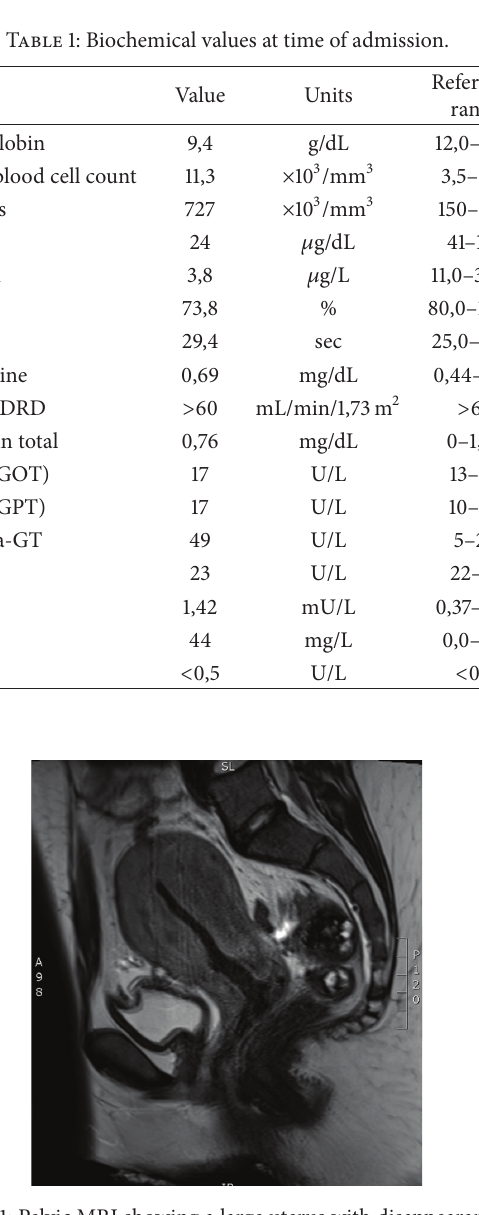
Figure 1: Pelvic MRI showing a large uterus with disappearance of its zonal anatomy, yet lacking any signs of an endometrial tumor.